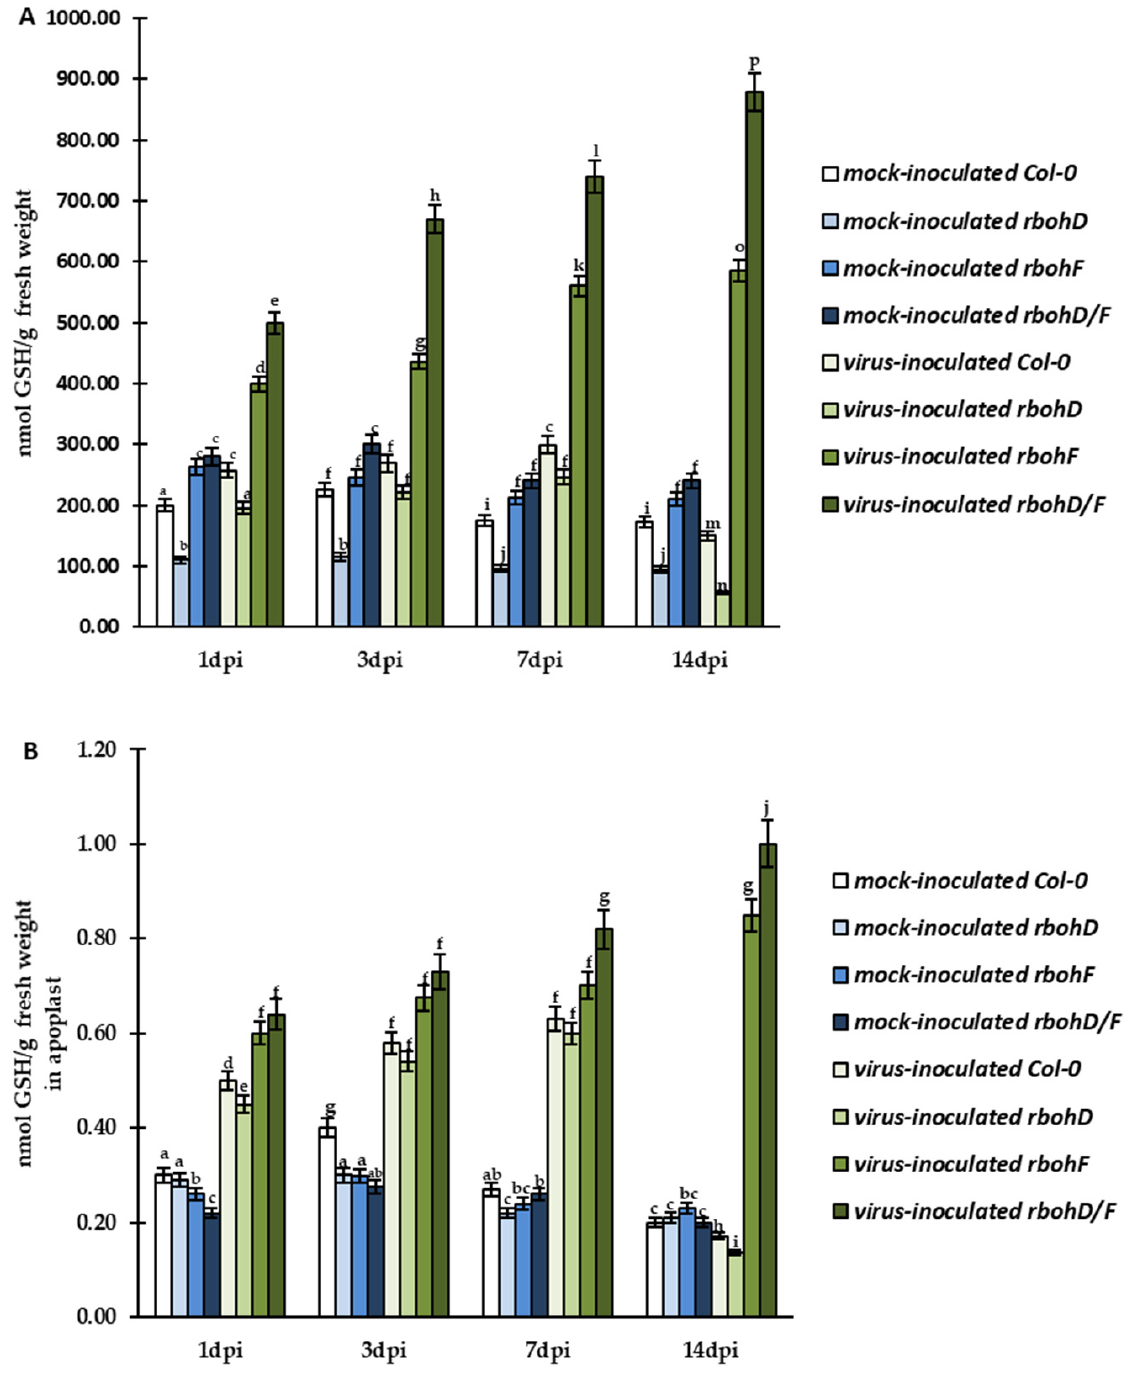
Figure 5. The mean concentration of cellular GSH ( A ) and apoplastic GSH ( B ) in the leaves of TuMV- and mock-inoculated Col-0, rbohD , rbohF , and rbohD/F plants between 1 and 14 dpi. Using ANOVA and Tukey’s HSD test, the mean concentrations of GSH and GSSG were calculated at p < 0.05. Statistically significant values are indicated by different letters above the bars.